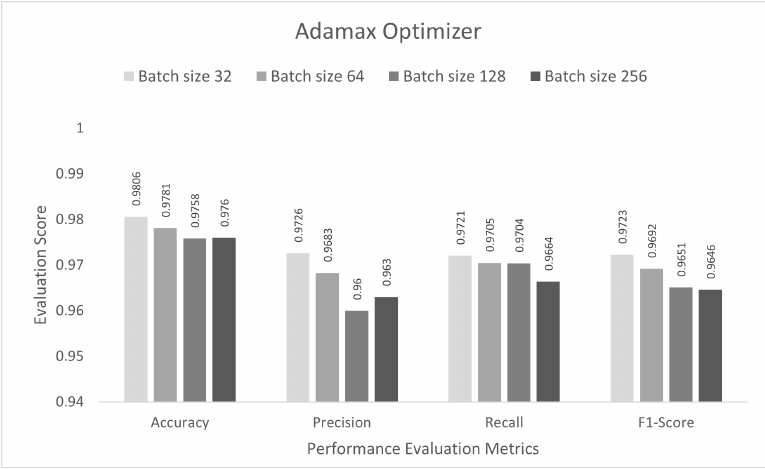
Figure 8. AdaMax optimizer for multi-class category classification